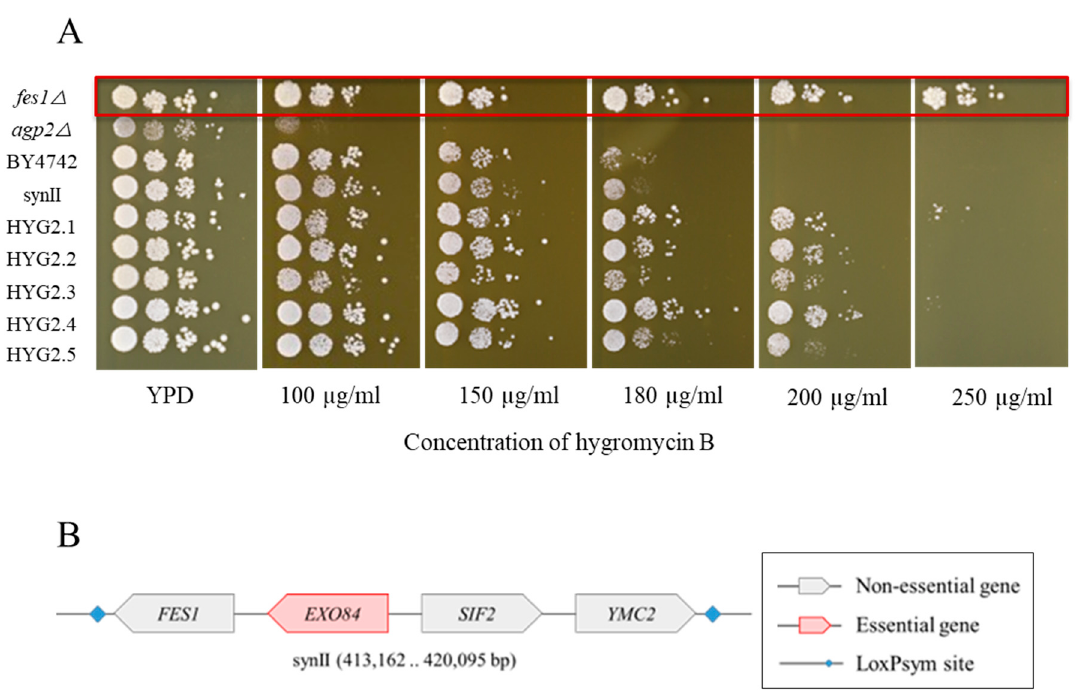
Figure 6. ( A ) Phenotypic analysis revealed that fes1 ∆ and agp2 ∆ had contrary effect on the hygromycin B resistance. Single knockout strains fes1 ∆ and agp2 ∆ , BY4742, synII, SCRaMbLEd strains HYG2.1-HYG2.5 were spotted on YPD plates containing different concentrations of hygromycin B. Plates were incubated at 30 °C and the photos were taken on day 3. fes1 ∆ increased the resistance towards hygromycin B [28], while agp2 ∆ led to sensitivity to hygromycin B in contrast to what was reported [27]. ( B ) The loxPsym sites flanking FES1 enclose 3 other genes, EXO84 , SIF2 and YMC2 , in which EXO84 is an essential gene.